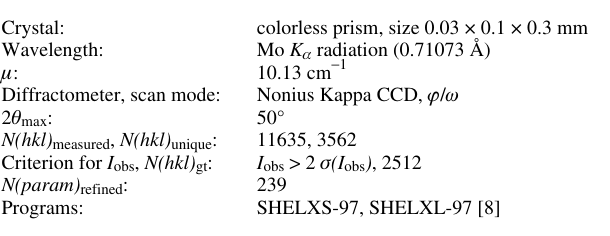
Table 1. Data collection and handling.